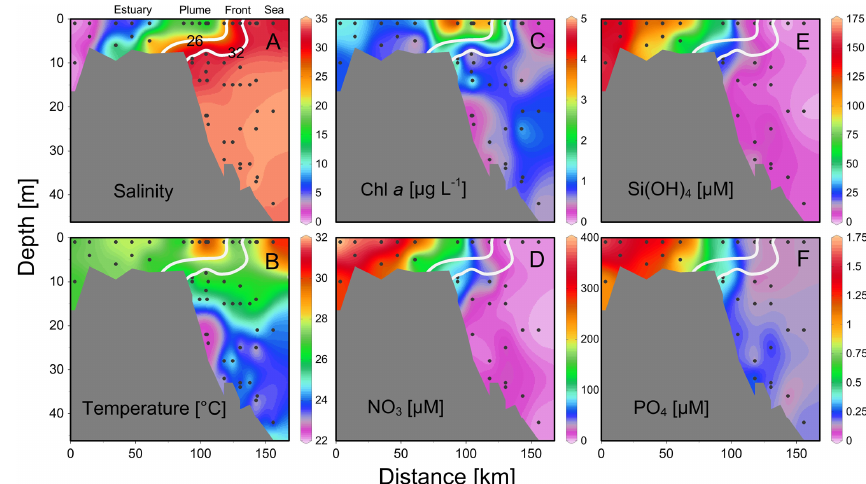
Figure 4. Vertical distributions of (a) salinity, (b) temperature, (c) chlorophyll a and (d) nitrate, (e) silicate and (f) phosphate across the front of the estuary to the sea. Location of the section during the three cruises is in Fig. 1. Two white lines are salinity levels of 26 and 32 for nearshore and offshore boundaries of the plume (see text for detail).